Question: Sum up the contents of this chart in one sentence.
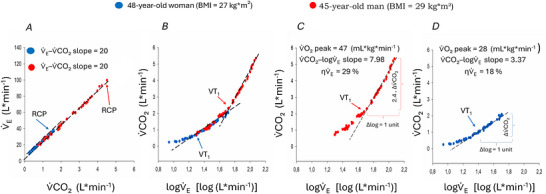
Answer: Comparative trajectories of the conventional V ˙ E – V ˙ C O 2 slope and the semi‐logarithmic V ˙ C O 2 –log V ˙ E relationship during incremental exercise in two healthy, physically active, non‐athlete participants Closed blue circles denote data from a 48‐year‐old woman (BMI = 27 kg m − 2 ), and closed red circles denote data from a 45‐year‐old man (BMI = 29 kg m − 2 ). A , the characteristic linear V ˙ E – V ˙ C O 2 slope, measured from exercise onset to the respiratory compensation point (RCP). B , the curvilinear (quadratic) relationship between V ˙ C O 2 and log V ˙ E , with linear regression applied to the segment beyond the first ventilatory threshold (VT 1 ). C and D , the individual responses extracted from B , using identical axis scales to facilitate direct comparison. For an equivalent interval of Δlog V ˙ E = 1 unit (a tenfold increase in ventilation), the male participant exhaled approximately 2.4 times more CO 2 than the female participant, corresponding to roughly a 60% reduction in ventilatory requirement for the same CO 2 removal and indicating substantially higher ‘ventilatory efficiency’ in the male subject. Importantly, this difference occurred despite both individuals exhibiting nearly identical V ˙ E – V ˙ C O 2 slopes in A . The male participant also achieved a higher peak V ˙ O 2 , and when referenced to maximal voluntary ventilation, his ventilatory efficiency index ( η V ˙ E ) reached 29%, reflecting the physiological significance of the semi‐logarithmic approach beyond VT 1 .